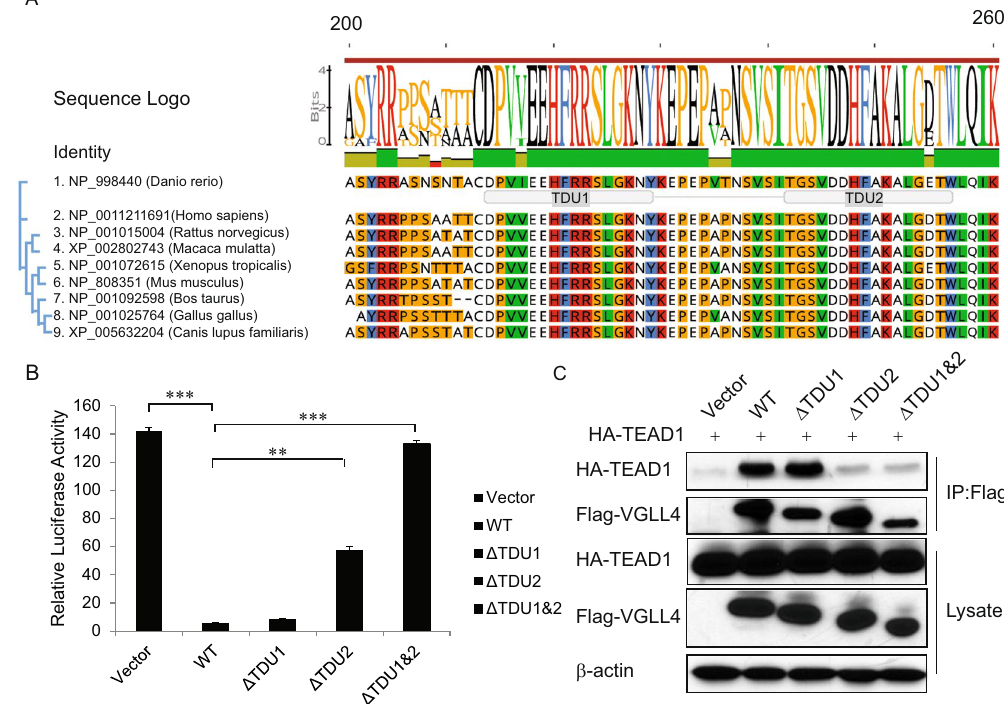
Figure 6. VGLL4 interacts with TEAD1 through the TDU2 domain. ( A ) Image of evolutionary conservation of VGLL4 and schematic representation of TDU1 and TDU2 domains. ( B ) VGLL4-WT or VGLL4- Δ TDU1 completely inhibits the TEAD response element reporter activity, whereas VGLL4- Δ TDU2 or VGLL4- Δ TDU1&2 fail to do so. ( C ) VGLL4 interacts with TEAD1 through its TDU2 domain. Co-immunoprecipitation of TEAD1 with the Flag-VGLL4 immunoprecipitation only observed in HEK293T cells co-transfected w/ TEAD1 and WT- or Δ TDU1-VGLL4 but not Δ TDU2- or Δ TDU1 Δ